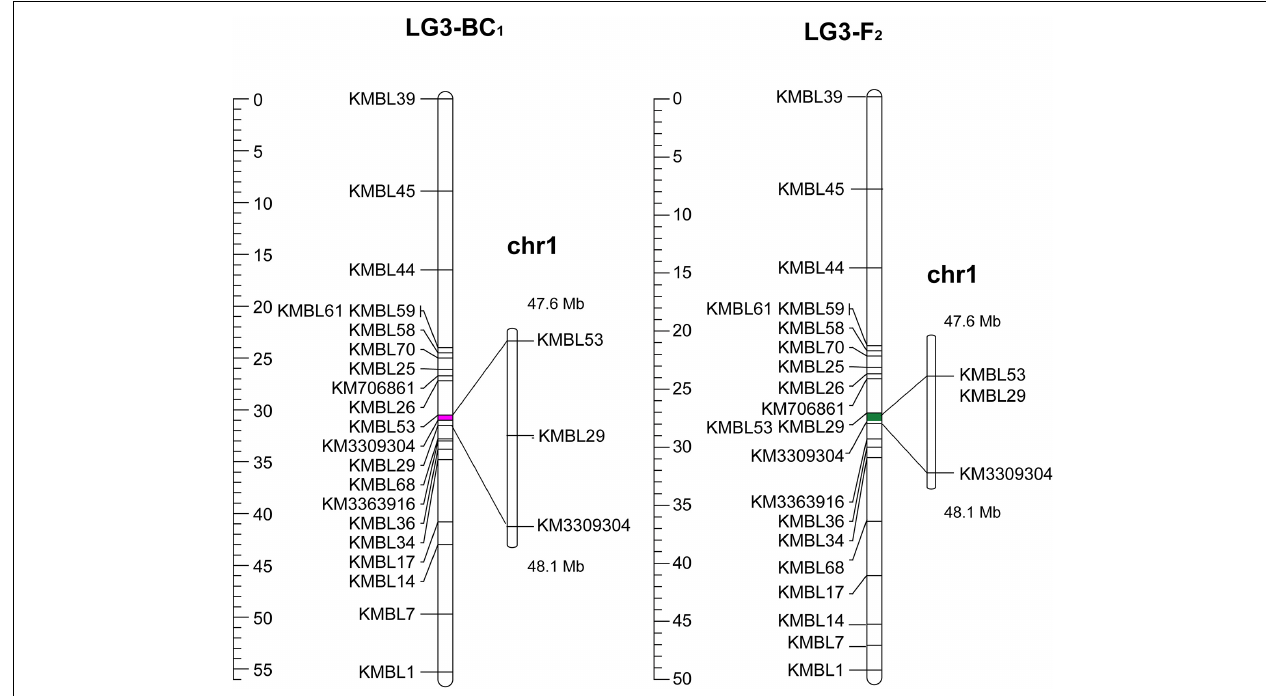
FIGURE 4 | QTL mapping of BC 1b and F 2 population: the left was the fine mapping of BC 1b population; the right was the fine mapping of F 2 population.